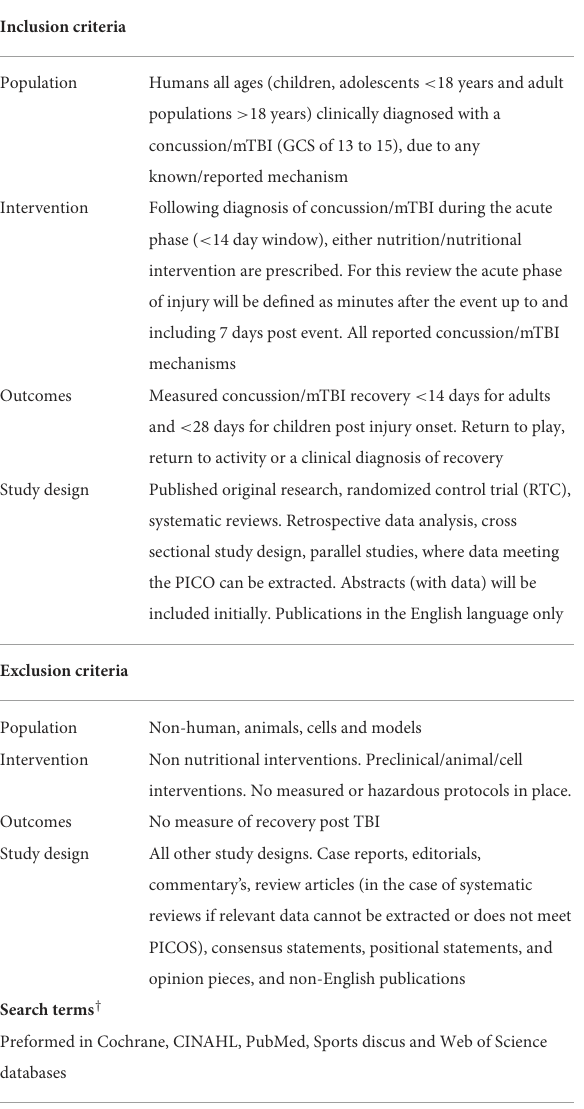
TABLE 1 PICOS-model and Medline search strategy in accordance with PRISMA